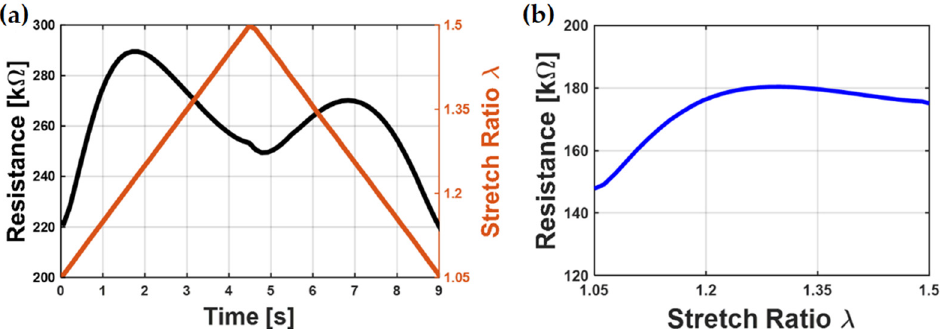
Figure 1. Typical bimodal behavior of DE resistance during stretching: ( a ) The electrical resistance and the stretch values over time, where the electrical resistance shows a bimodal behavior; ( b ) Electrical resistance over stretch: The resistance first increases but decreases again after reaching a maximum.